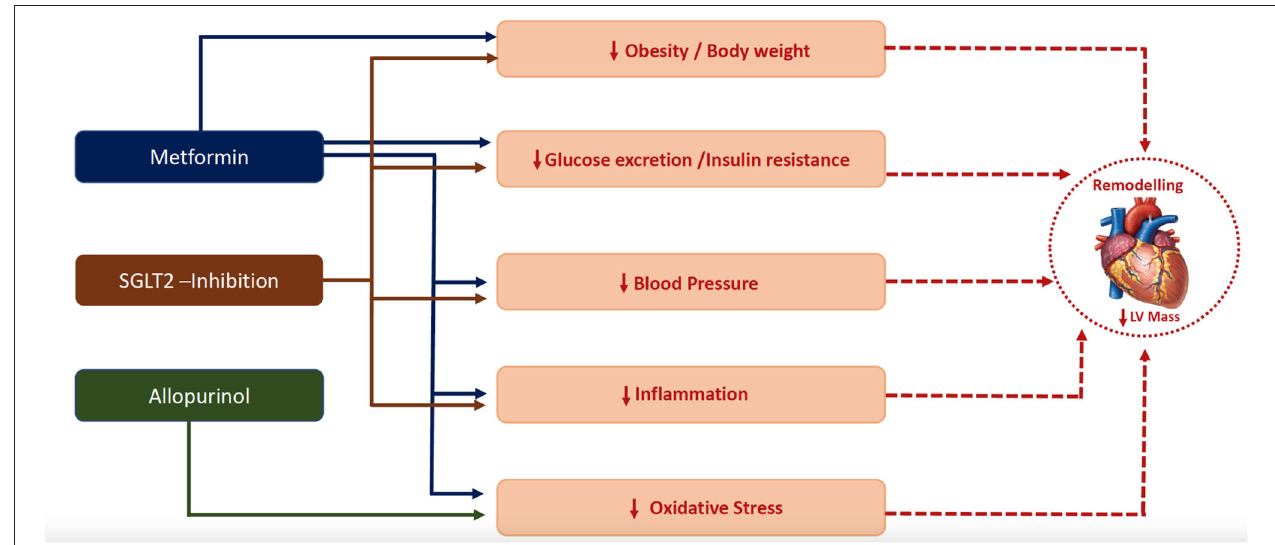
FIGURE 2 | Plausible mechanisms by which metformin (111), SGLT-2 inhibitor (128) and allopurinol (17, 18) regressed left ventricular hypertrophy.